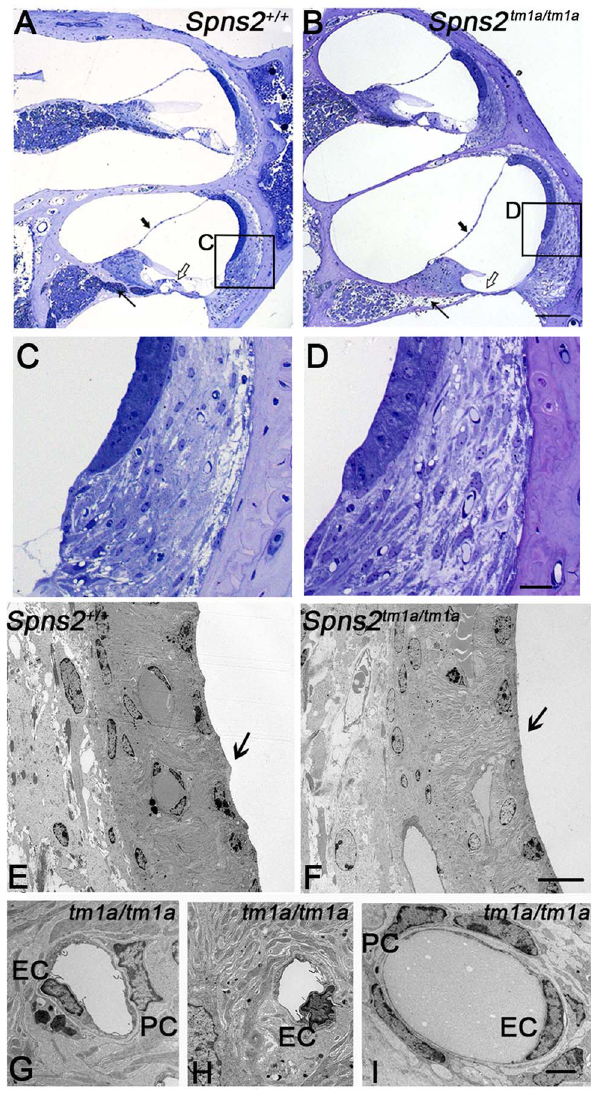
Figure 6. Pathological changes in stria vascularis and normal position of Reissner’s membrane. A,B In semi-thin sections (P28), the position of Reissner’s membrane is not changed (bold arrow). Hair cells and supporting cells of the most basal turn have degenerated (open arrow). The neural dendrites in Rosenthal’s canal appeared reduced (arrow). Scale bar: 100 m m. C and D are expanded views of the areas framed in A and B and display similar morphology of fibrocytes in mutants and controls. Scale bar 20 m m. By transmission electron microscopy (P28, E–I ), the normal scallop-shaped (bold arrow) luminal boundary of marginal cells in control mice ( E ) was not found in the Spns2 tm1a/tm1a mice ( F ). Abnormalities were seen in nuclei of endothelial cells (EC) and pericytes (PC) in strial capillaries of Spns2 tm1a/tm1a mice ( G,H ), which were not seen in the capillaries of spiral ligament ( I ) and control strial capillaries ( E ). Scale bars: 10 m m in E,F , 2 m m in G–I . proteins in adults is secondary to a primary dysfunction of EP generation. We generated the conditional allele of Spns2 ( Spns2 tm1c ) by crossing the Spns2 tm1a allele to a line expressing Flp recombinase to excise the inserted cassette (Fig. 1A). The Spns2 tm1c / tm1c mice